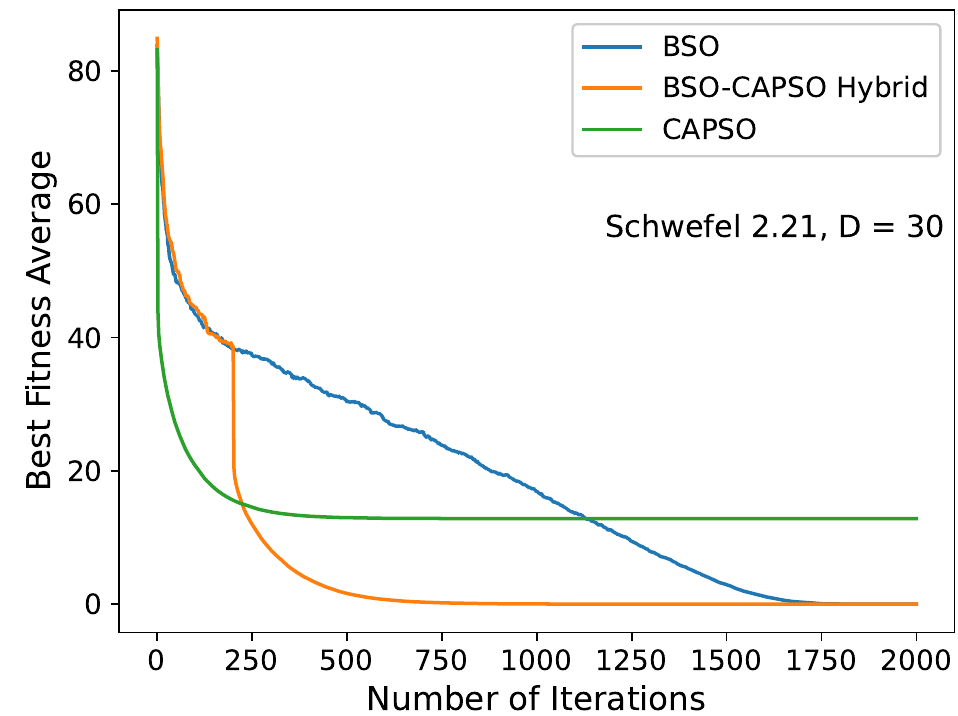
Figure 9. Convergence diagram of the stand-alone BSO, BSO–CAPSO hybrid and stand-alone CAPSO algorithms for the Schwefel 2.21 ( f 3 ) function with D = 30. Convergence acceleration occurred after t switch =